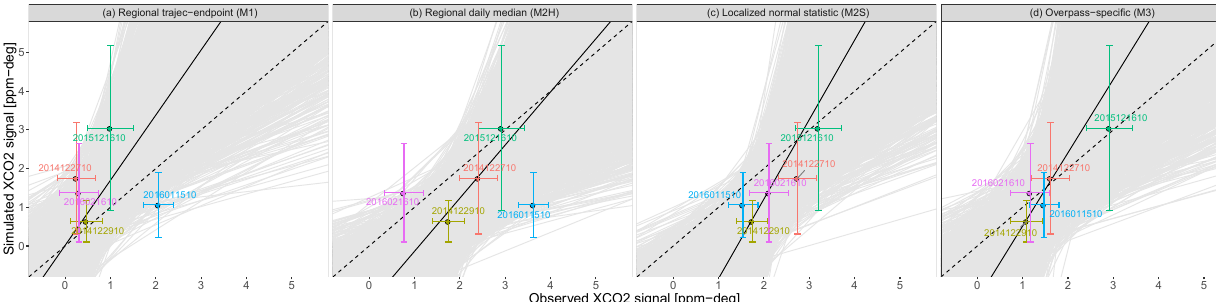
Figure 9. Correlation between observed and simulated anthropogenic XCO 2 signals for five overpasses. Colors differentiate different satellite overpass dates. Model–data comparisons using GDAS-derived XCO 2 signals and observed signals based on different background methods. Error bars along the x axis and y axis represent the overall observed uncertainty (represented as 1 σ , including the XCO 2 spatial variability, background uncertainty, and retrieval errors) associated with observed signals and the overall modeled uncertainty (1 σ , including emission uncertainty and transport uncertainty) around modeled signals. The dashed line represents the 1 : 1 line. Monte Carlo experiments are per- formed to fit linear regression lines based on sampled model–data signals and the associated errors. Regression lines with positive slopes are shaded in light gray. Median values of the slopes and y intercepts from the multiple regression lines (with positive slopes) are used to draw a linear regression (black solid